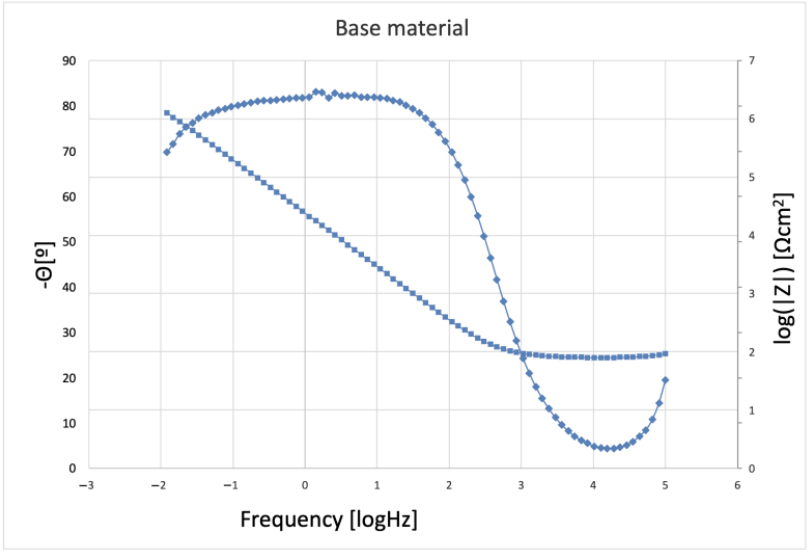
Figure 10. Bode plot for the initial state of the sample (obtained from the manufacturer) .